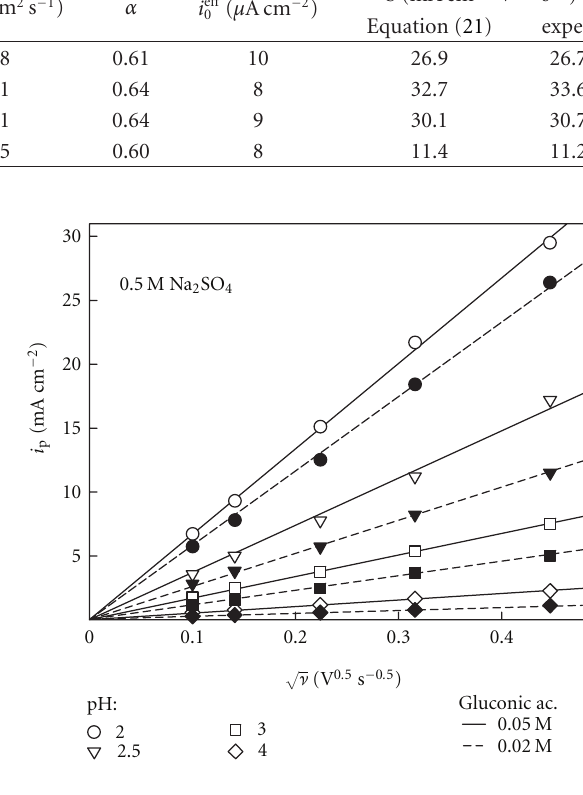
√ ν obtained at di ff erent